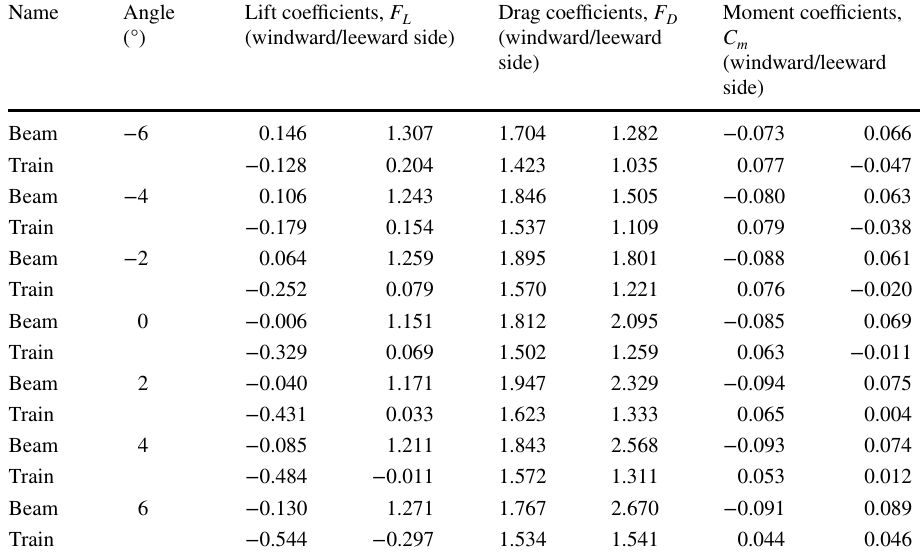
Table 2 Mean wind aerodynamic coefficients of bridge and